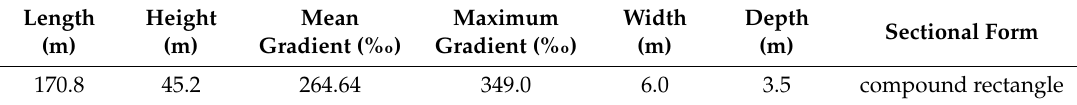
Table 2. The structural design parameters of the drainage channel of the Xiaogangjian debris flow.